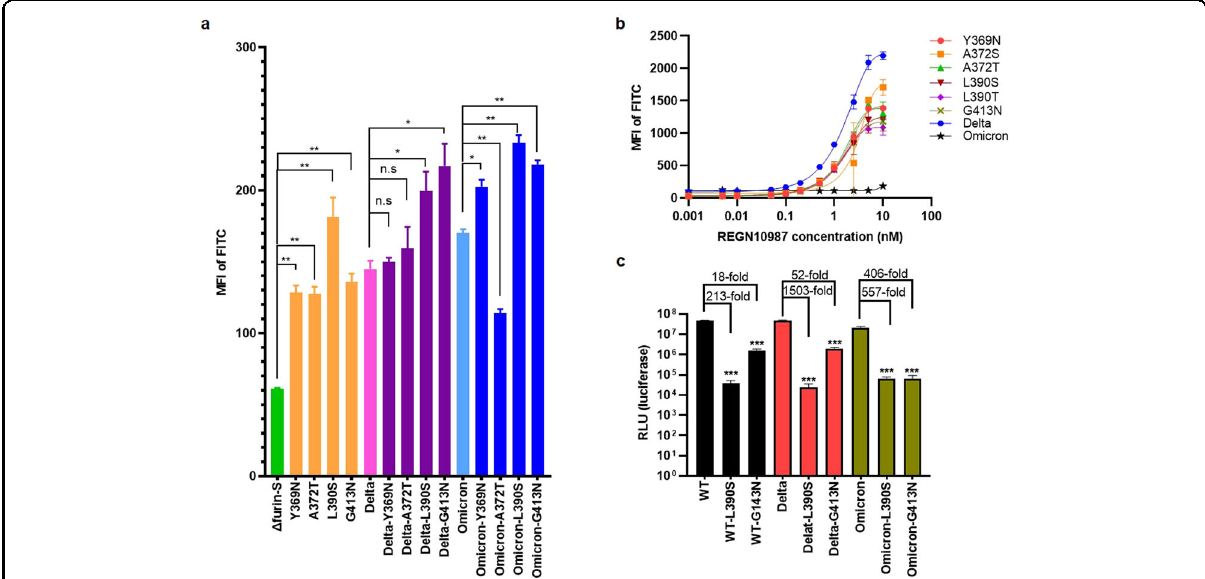
Fig. 4 Novel adding N -glycan sites improved af fi nity but weakened infectivity. a MFI of FITC in the context of Δ furin-S, Delta-S, and Omicron-S, and their corresponding more N -glycans cell lines. The t -test analysis was indicated as: n.s., P > 0.05, * P < 0.05, ** P < 0.01, *** P < 0.001. b MFI of FITC in manually added N -glycan cell lines (Y369N, A372S/T, L390S/T, and G413N), with the incubation of gradient REGN10987 (0, 0.001, 0.005, 0.01, 0.05, 0.1, 0.2, 0.5, 1, 2.5, 5, 10 nM). Delta and Omicron were set as the control. c The relative infectivity of WT-S, Delta-S, Omicron-S, and their corresponding L390S and G413N pseudoviruses, measuring by the read-out of luciferase